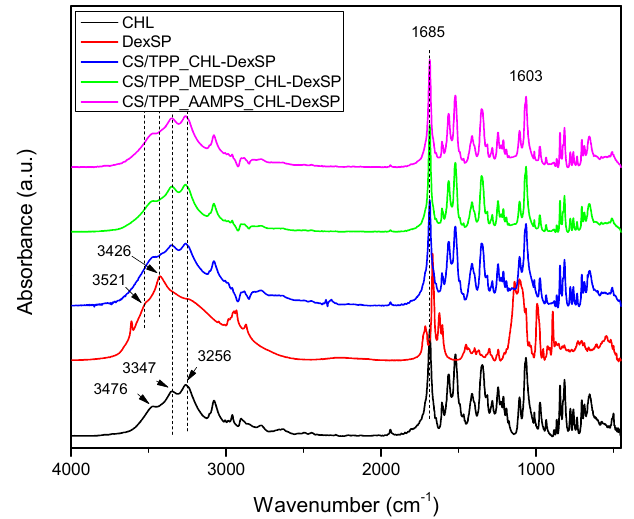
Figure 9. FT-IR spectra of neat drugs and encapsulated in CS, CS-AAMPS and CS-MEDSP